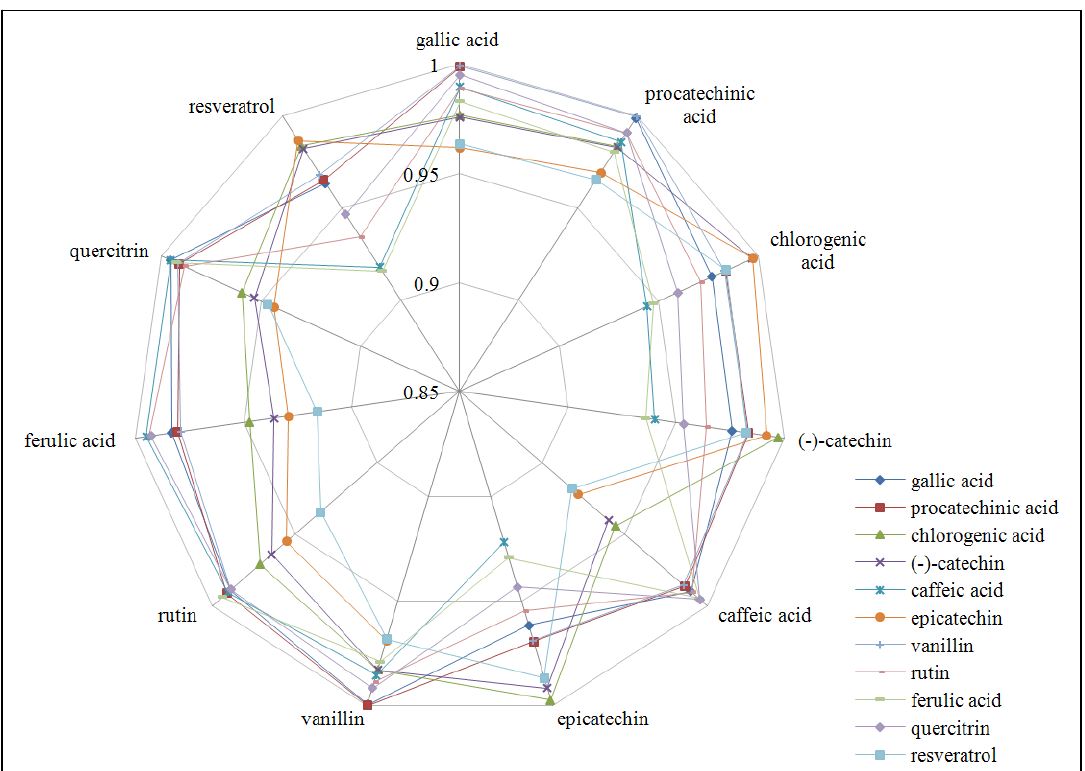
Figure 4. The correlation between the contents of the certain phenolic compounds at P <